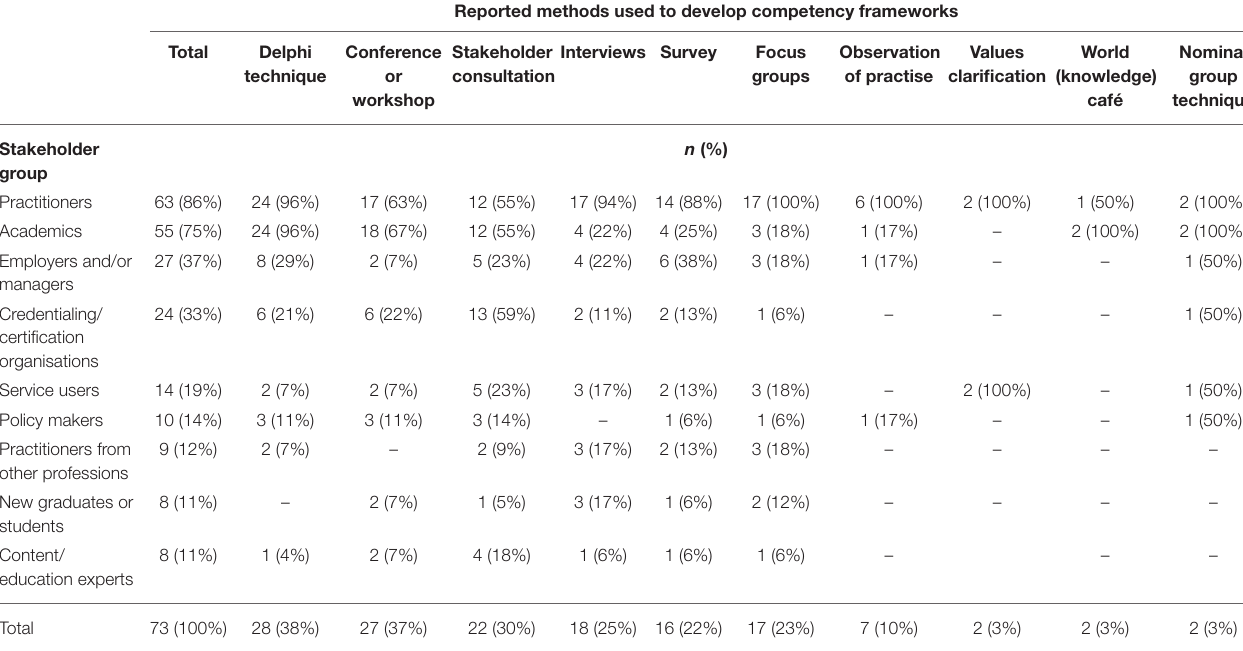
TABLE 3 | Stakeholder engagement across reported methods used to develop a competency framework in health